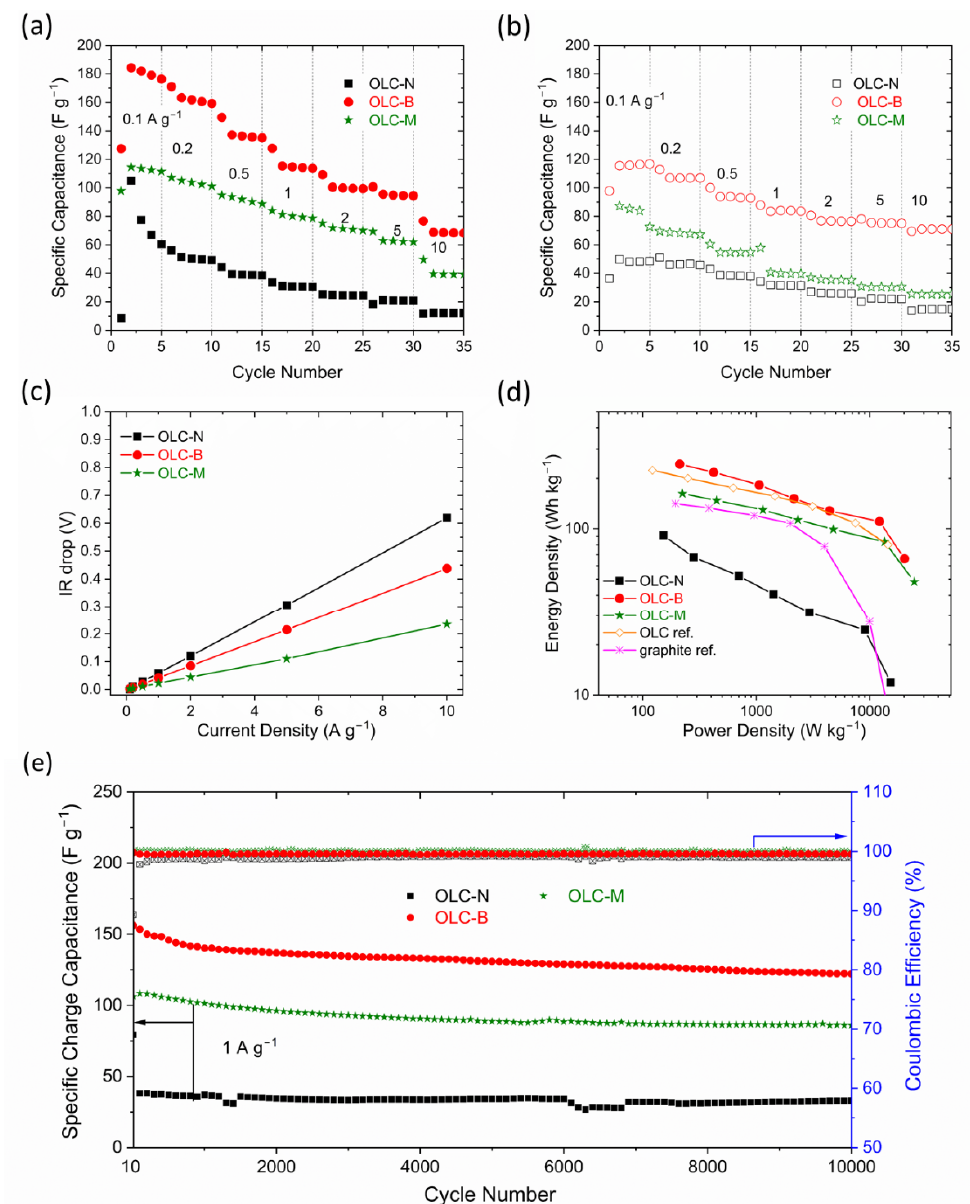
Figure 6. Electrochemical performance of LICs with varying OLCs ( a ), GCPL rate performance (current rates in A − 1 ) of fresh LIC cells, and ( b ) GCPL rate performance (current rates in A g − 1 ) after 1000 cycles at 1 A g − 1 for the same cells in ( a ). ( c ) IR drop at every current density in ( a ), ( d ) Ragone plot (normalized to active material in all electrodes) in comparison with the results of our previous study, and ( e ) GCPL cycling performance at a high current rate of 1 A g − 1 (normalized to active material in anodes).